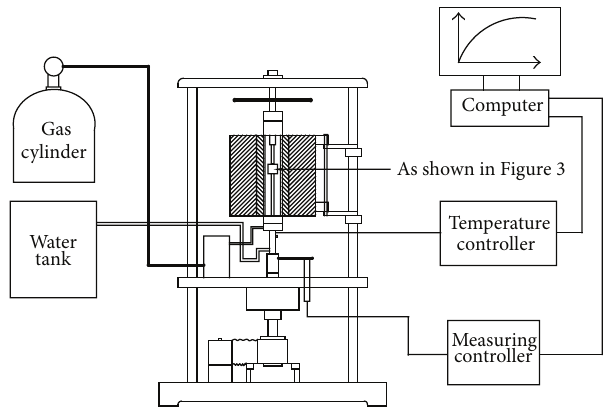
Figure 2: Schematic diagram of the test